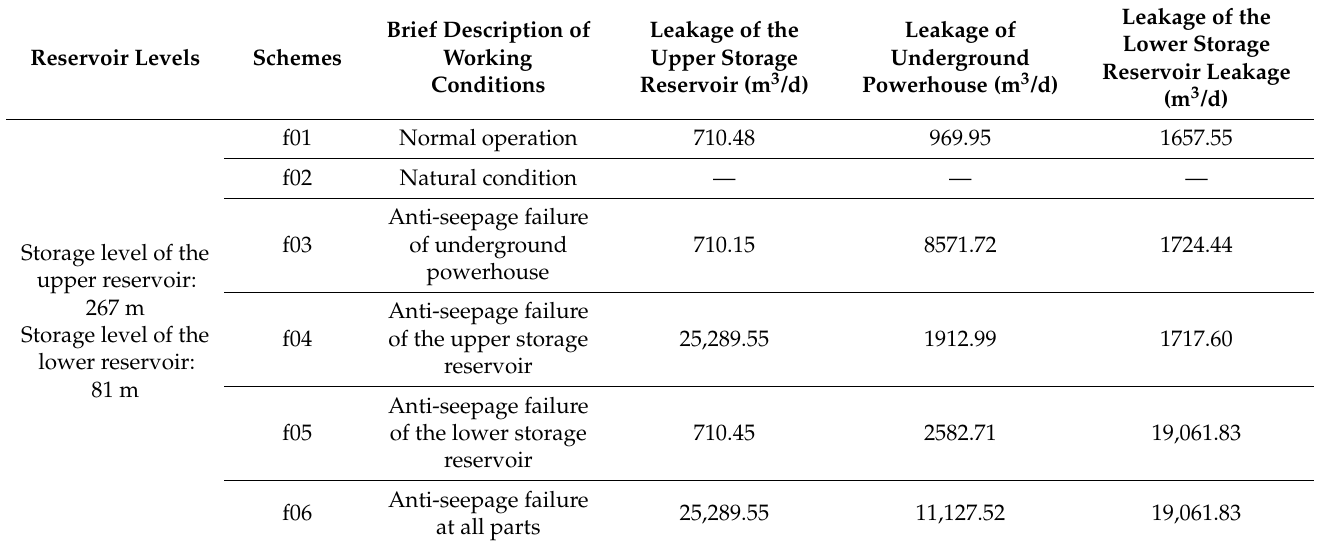
Table 6. Statistical results of leakage